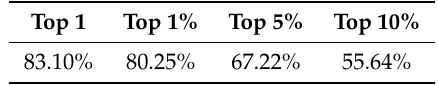
Table 1. Precision of DCNN model prediction.